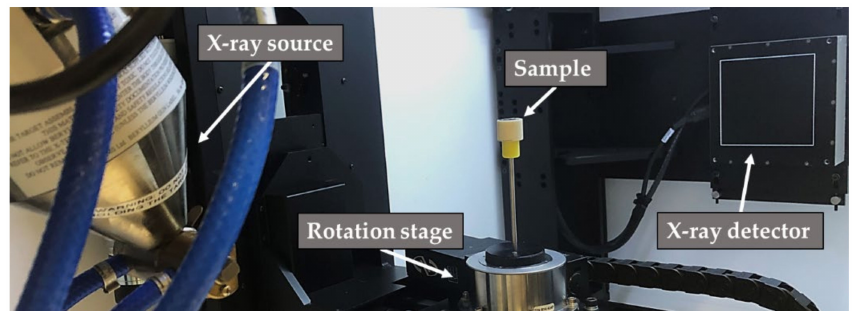
Figure 5. Setup of CT scanning with